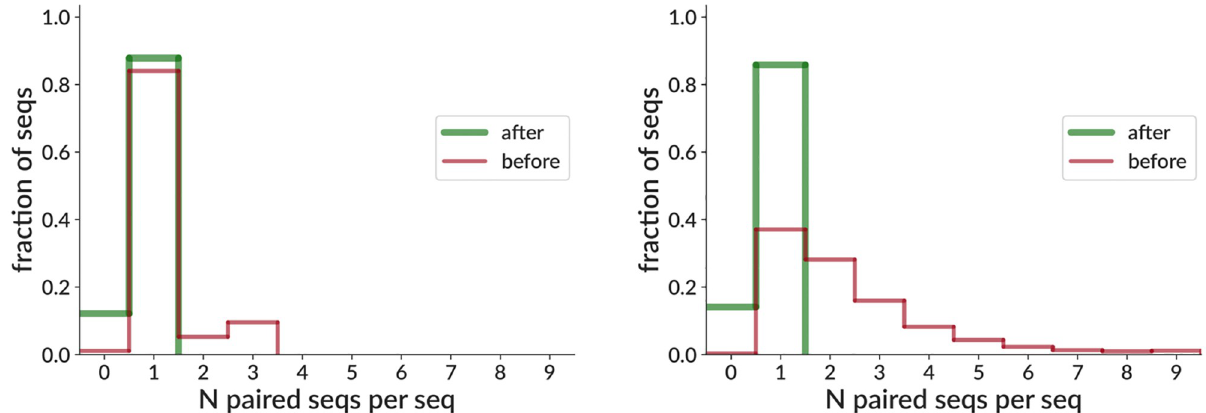
Fig 8. Pair info cleaning effectiveness on real data for a relatively well-paired sample (left, same sample as Fig 7) and a sample with substantial numbers of multiply-paired sequences (right, not yet published, but raw data included in https://doi.org/10.5281/zenodo.5860143). The x axis shows the number of sequences paired with each sequence (“paired seqs per seq”) before and after application of our pair info cleaning algorithm. Thus for example a perfectly paired sample (with perfect allelic exclusion, no dropout, etc.) would have all sequences in the 1-bin (i.e. uniquely paired), while a sample with two cells in each droplet would have all sequences in the 3-bin. So an ideal application of our algorithm would leave every sequence uniquely paired (all in the 1-bin), but in practice some are left unpaired (0-bin).